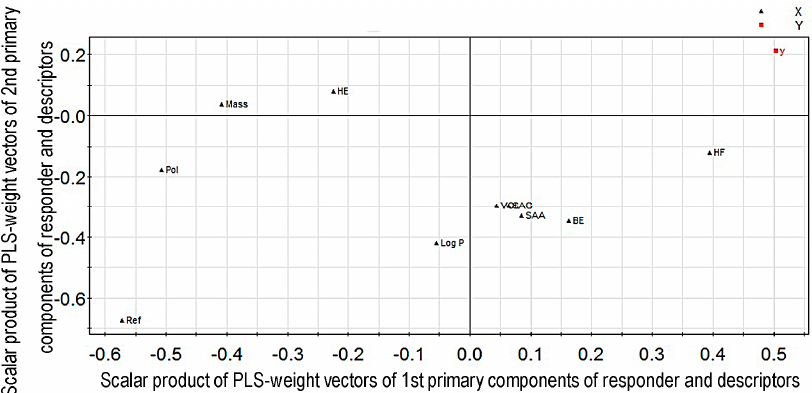
Figure 2. The loading plot of PLS-weight vectors for the first two primary components in the QSAR model